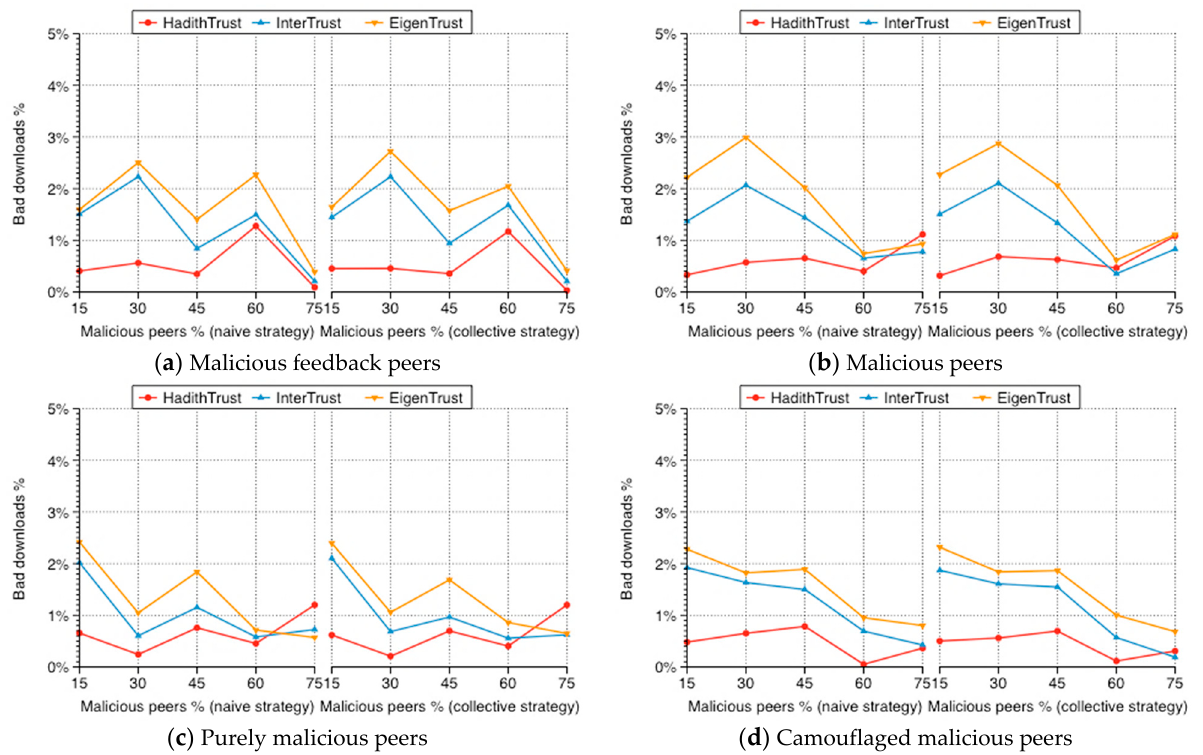
Figure 16. Percentage of bad downloads.